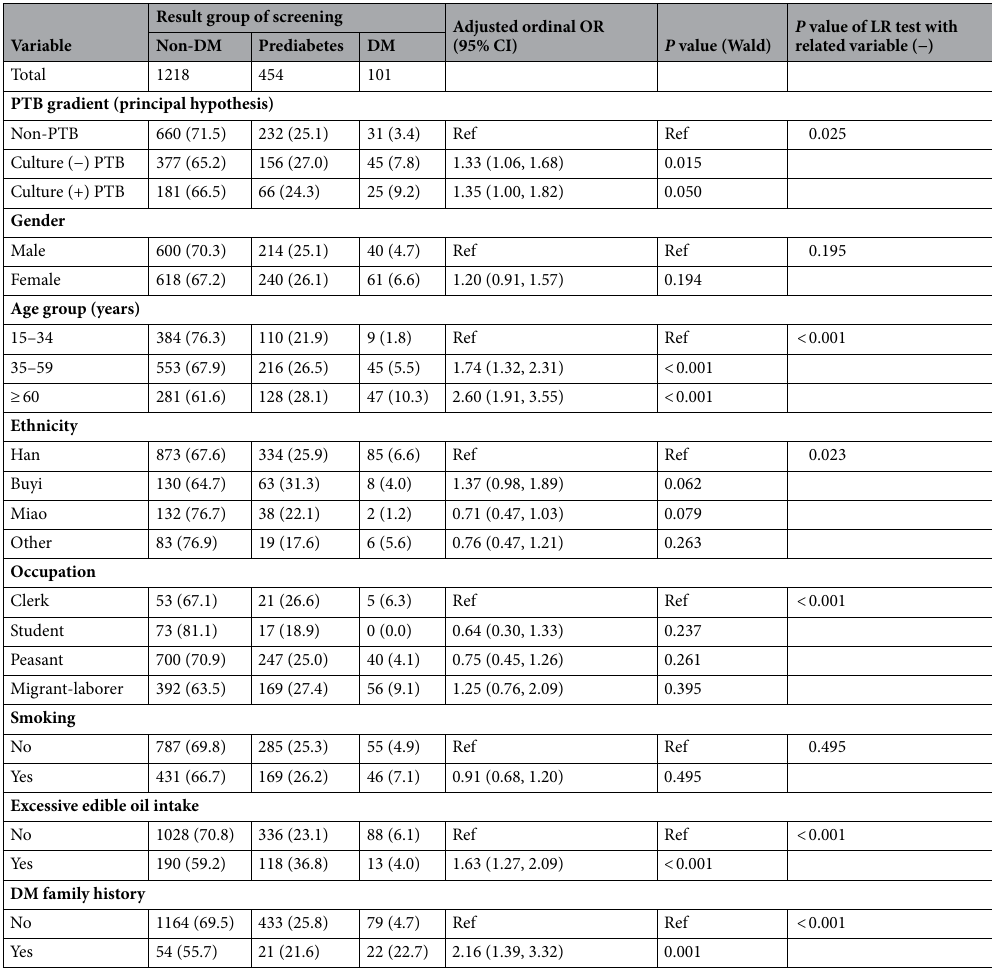
Table 4. Proportional odds logistic regression analysis for assessing the gradient association of tuberculosis on developing diabetes mellitus among households with a tuberculosis case, 2020 (n, %). LR test: likelihood ratio test. Excessive edible oil intake: intake of edible oil over 30 g/day/adult. Smoking: smoking in the past 12 months, including both daily and non-daily